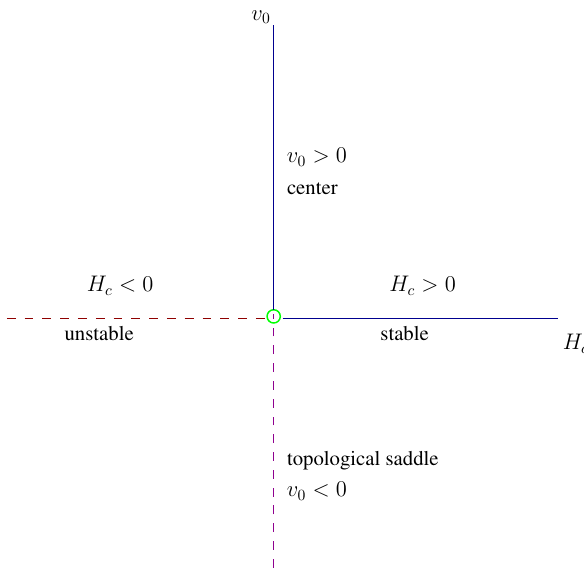
Fig. 6 Bifurcation diagram for v 0 =